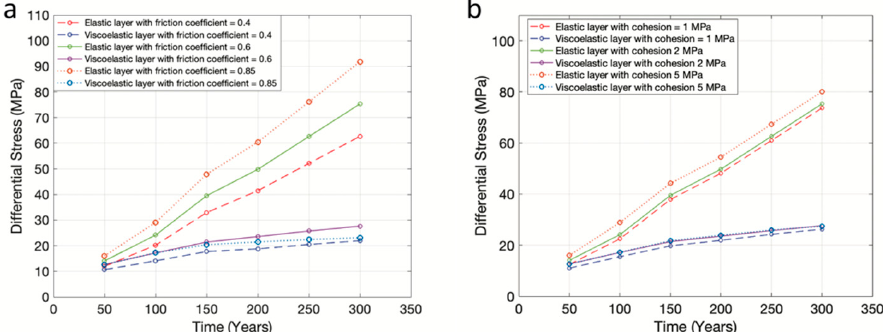
Figure 5. Slip magnitude of strain buildup model based on different friction coefficients and cohesion values in three scenarios: ( a ) scenario one, ( b ) scenario two, and ( c ) scenario three.